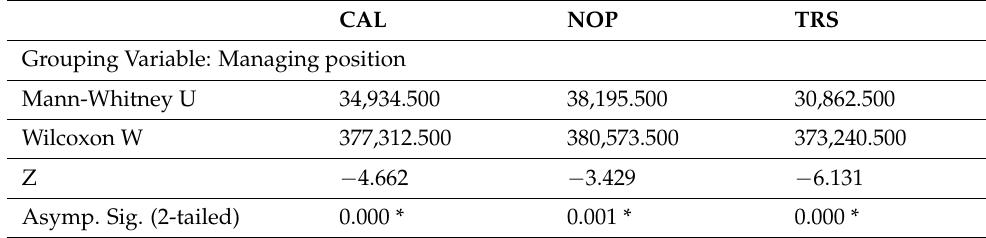
Table 6. Significant differences in the Management of Quality of Education component results between teacher groups (Mann–Whitney and Kruskal–Wallis